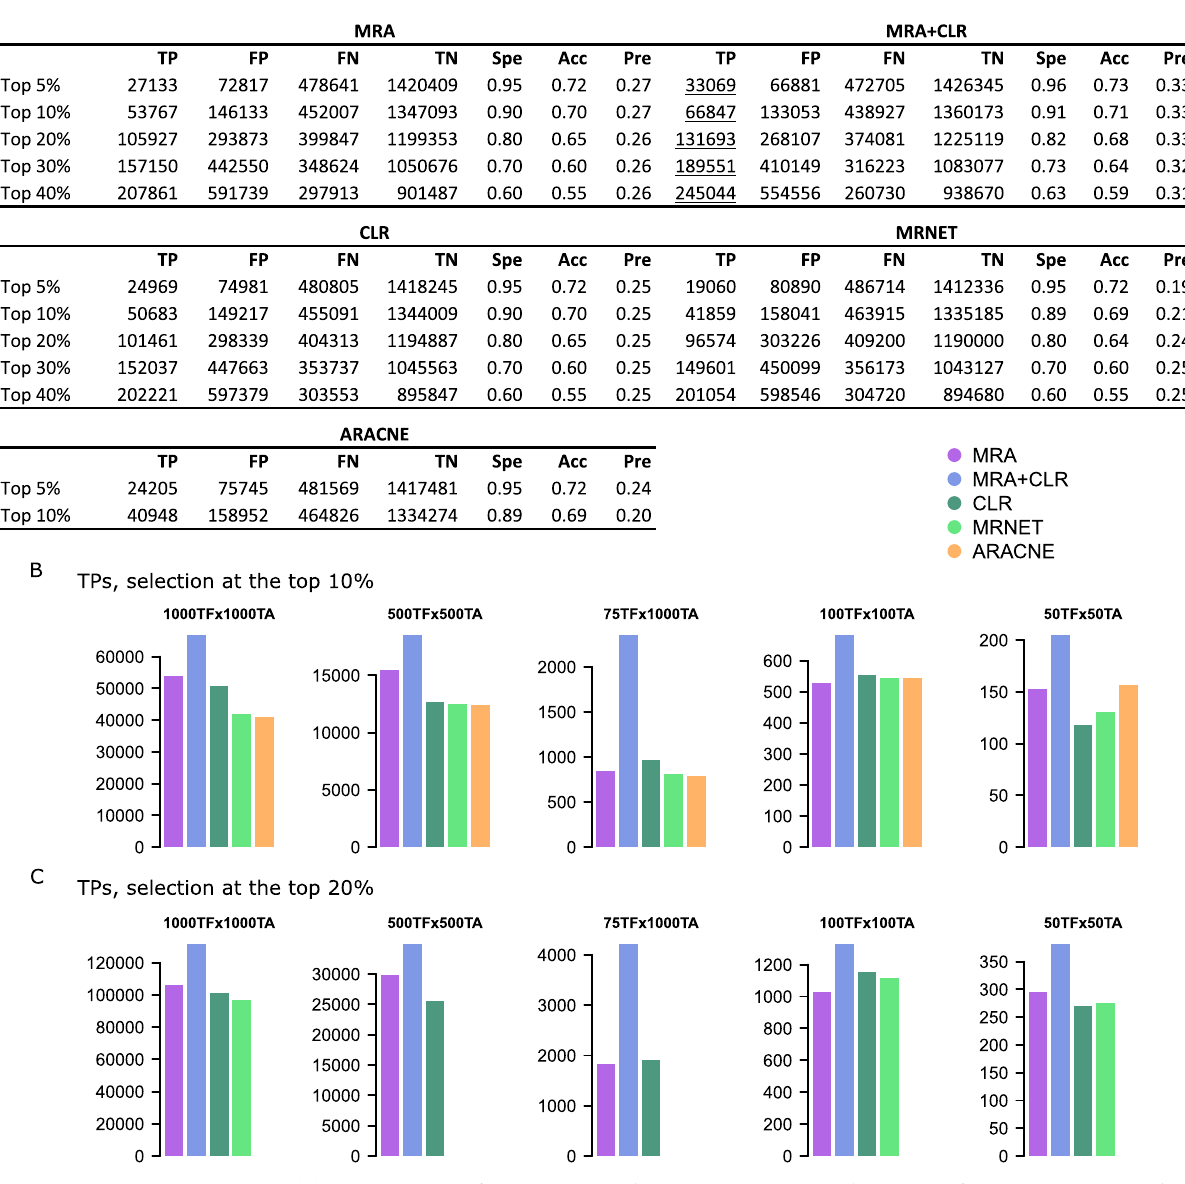
Fig 1. Performance on synthetic data. (A) Representative confusion matrices on the 1000TFx1000TA network. Spe = specificity, Acc = accuracy, and Pre = precision. Underlined values represent maxima. (B) TP numbers at the top 10% selection level in each network model. (C) TP numbers at the top 20% selection level. Note that in some cases, MRNET and ARACNE did not returned enough interactions to perform a number of selections equal to the top 20% of all possible interactions. We ignored those cases, hence the missing bars and numbers.